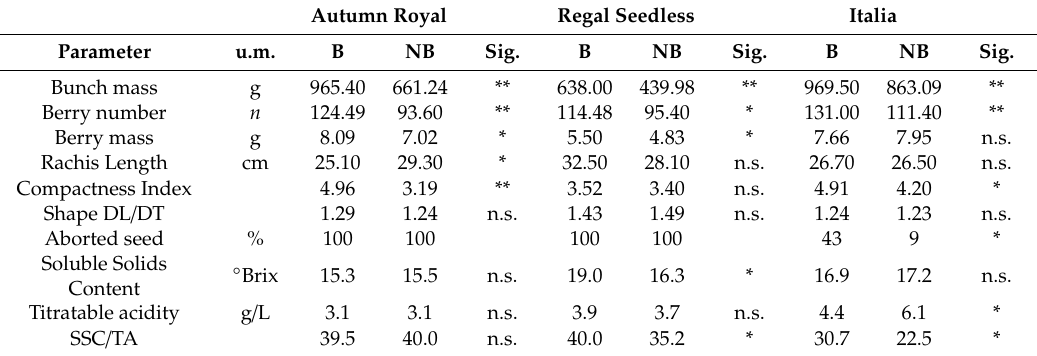
Table 2. Fruit quality parameters for bagged (B) and not bagged (NB) grapes: bunch mass (g), berry number, berry mass (g), rachis length (cm), compactness index, shape (longitudinal and transversal diameter, DL / DT), percentage of aborted seeds, SSC (soluble solid content, ◦ Brix), titratable acidity (g / L), and soluble solid content / titratable acidity ratio (SSC / TA). Autumn Royal Regal Seedless Italia Parameter u.m. B NB Sig. B NB Sig. B NB Sig. Bunch mass g 965.40 661.24 ** 638.00 439.98 ** 969.50 863.09 ** Berry number n 124.49 93.60 ** 114.48 95.40 * 131.00 111.40 ** Berry mass g 8.09 7.02 * 5.50 4.83 * 7.66 7.95 n.s. Rachis Length cm 25.10 29.30 * 32.50 28.10 n.s. 26.70 26.50 n.s. Compactness Index 4.96 3.19 ** 3.52 3.40 n.s. 4.91 4.20 * Shape DL / DT 1.29 1.24 n.s. 1.43 1.49 n.s. 1.24 1.23 n.s. Aborted seed % 100 100 100 100 43 9 * Soluble Solids ◦ Brix 15.3 15.5 n.s. 19.0 16.3 * 16.9 17.2 n.s. Content Titratable acidity g / L 3.1 3.1 n.s. 3.9 3.7 n.s. 4.4 6.1 * SSC / TA 39.5 40.0 n.s. 40.0 35.2 * 30.7 22.5